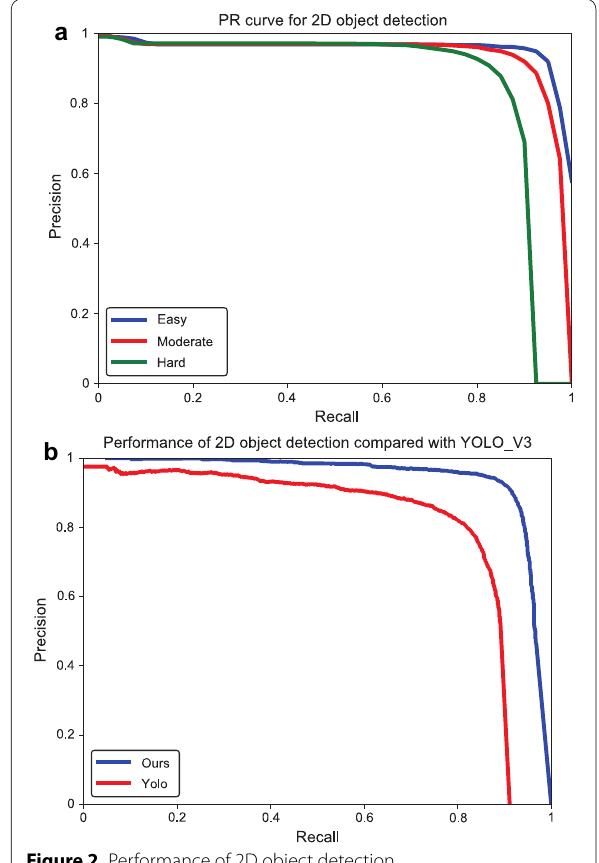
Figure 2 Performance of 2D object detection